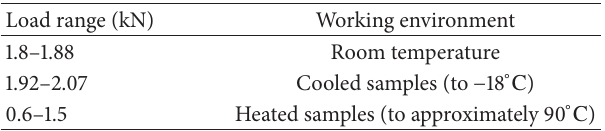
Table 1: Range of the applied